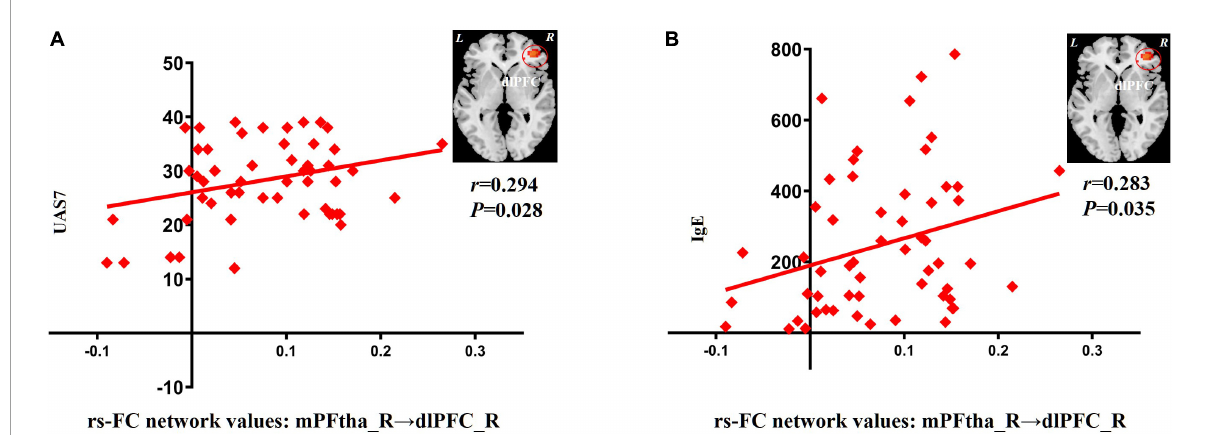
FIGURE2 Correlation between increased rs-FC network values and clinical indicators. (A) The increase of rs-FC network values between the mPFtha_R and the dlPFC_R was positively correlated with UAS7 ( r = 0.294; P = 0.028). (B) The increase of rs-FC network values between the mPFtha_R and the dlPFC_R was positively correlated with IgE ( r = 0.283; P = 0.035). rs-FC, resting-state functional connectivity; L, left; R, right; mPFtha, medial prefrontal thalamus; dlPFC, dorsal lateral prefrontal cortex; UAS7, urticaria activity score 7; IgE, immunoglobulin